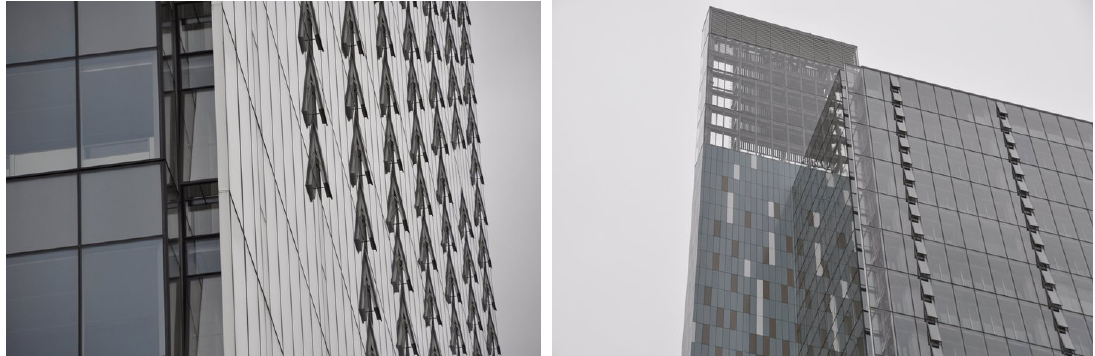
Figure 11. Manitoba Hydro Place, Double Skin Façade (Courtesy Terri Boake, University of Waterloo).